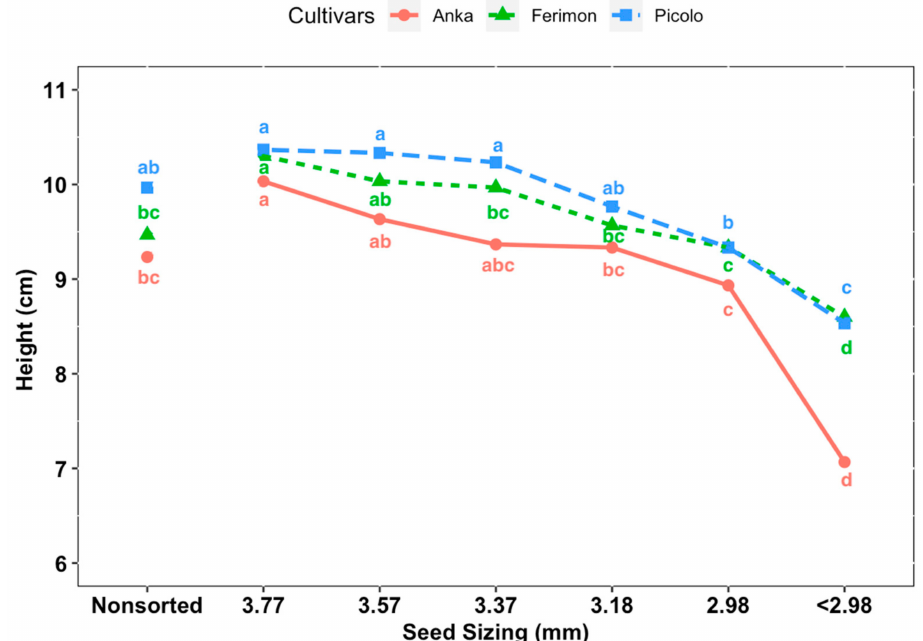
Figure 7. Height of baby leaf hemp cultivars ‘Anka’, ‘Ferimon’ and ‘Picolo’ in response to seed size treatment. Data represent mean of 15 experimental units (3 crop cycles each with 5 experimental units per treatment). Letters represent mean separation comparison using Tukey’s HSD (alpha =